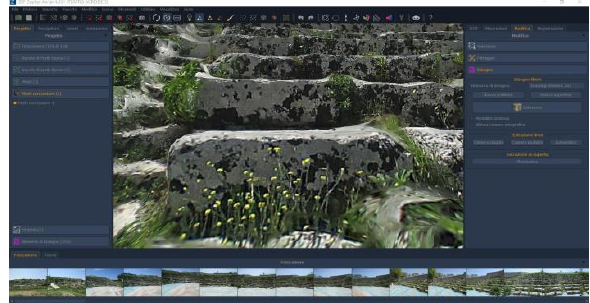
Figure 2 - Palazzolo Acreide theater, detail image of the mesh